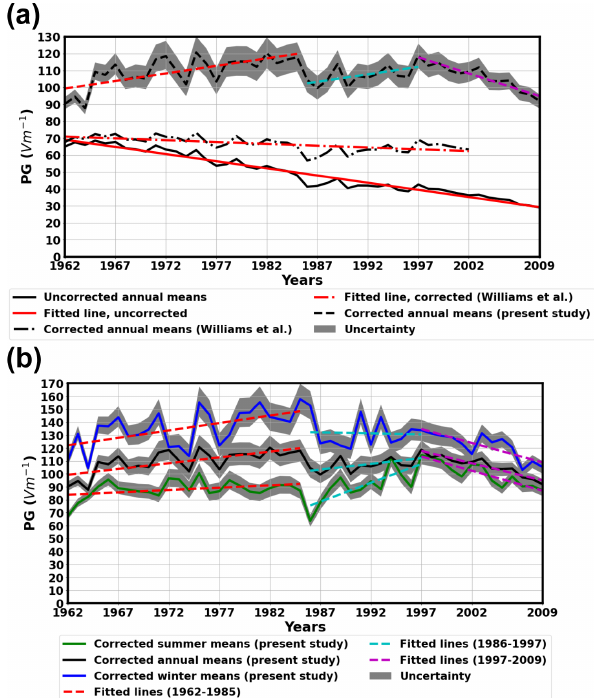
Figure 5. PG values recorded at NCK. (a) Annual means of uncor- rected and corrected records. (b) Annual, summertime, and winter- time averages of the corrected records. Dashed lines correspond to linear regressions on the time series (see Table